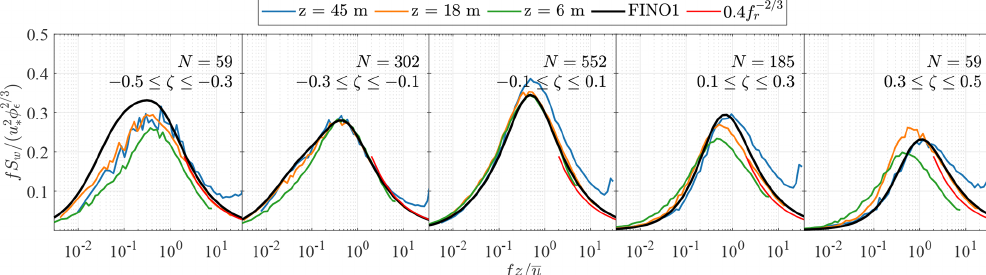
Figure 10. Normalised spectra of the vertical wind component at 45, 18, and 6ma.m.s.l. for various stability conditions. The red curve is derived from Eq. (6), and N denotes the number of samples considered for ensemble